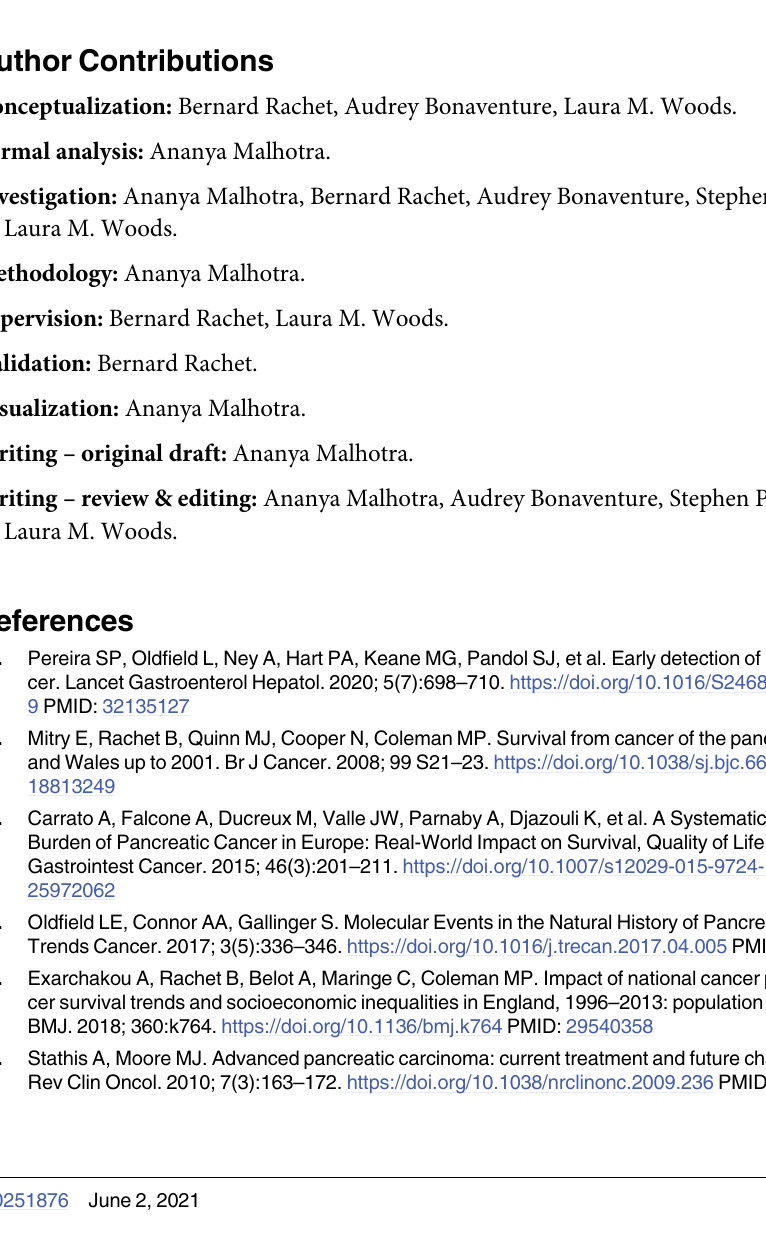
S5 Table. Random forest model fitted at month 17 before diagnosis for age-group above 60